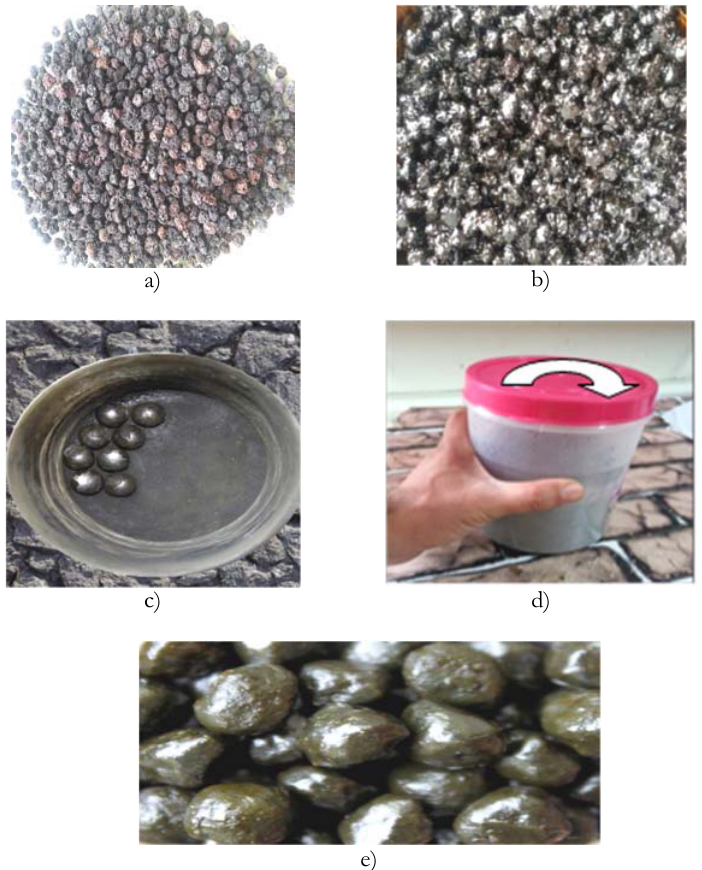
Figure 2: Encapsulation procedure step by step; a) Dry and cleaned porous sands (particle size about 2.3 to 2.8 mm), b) Porous sands with rejuvenator inside the grains, c) Container with a diameter of 2 cm steel balls, d) Energetically circles movement for 15 s, e) The sieved capsules between 3 and 4